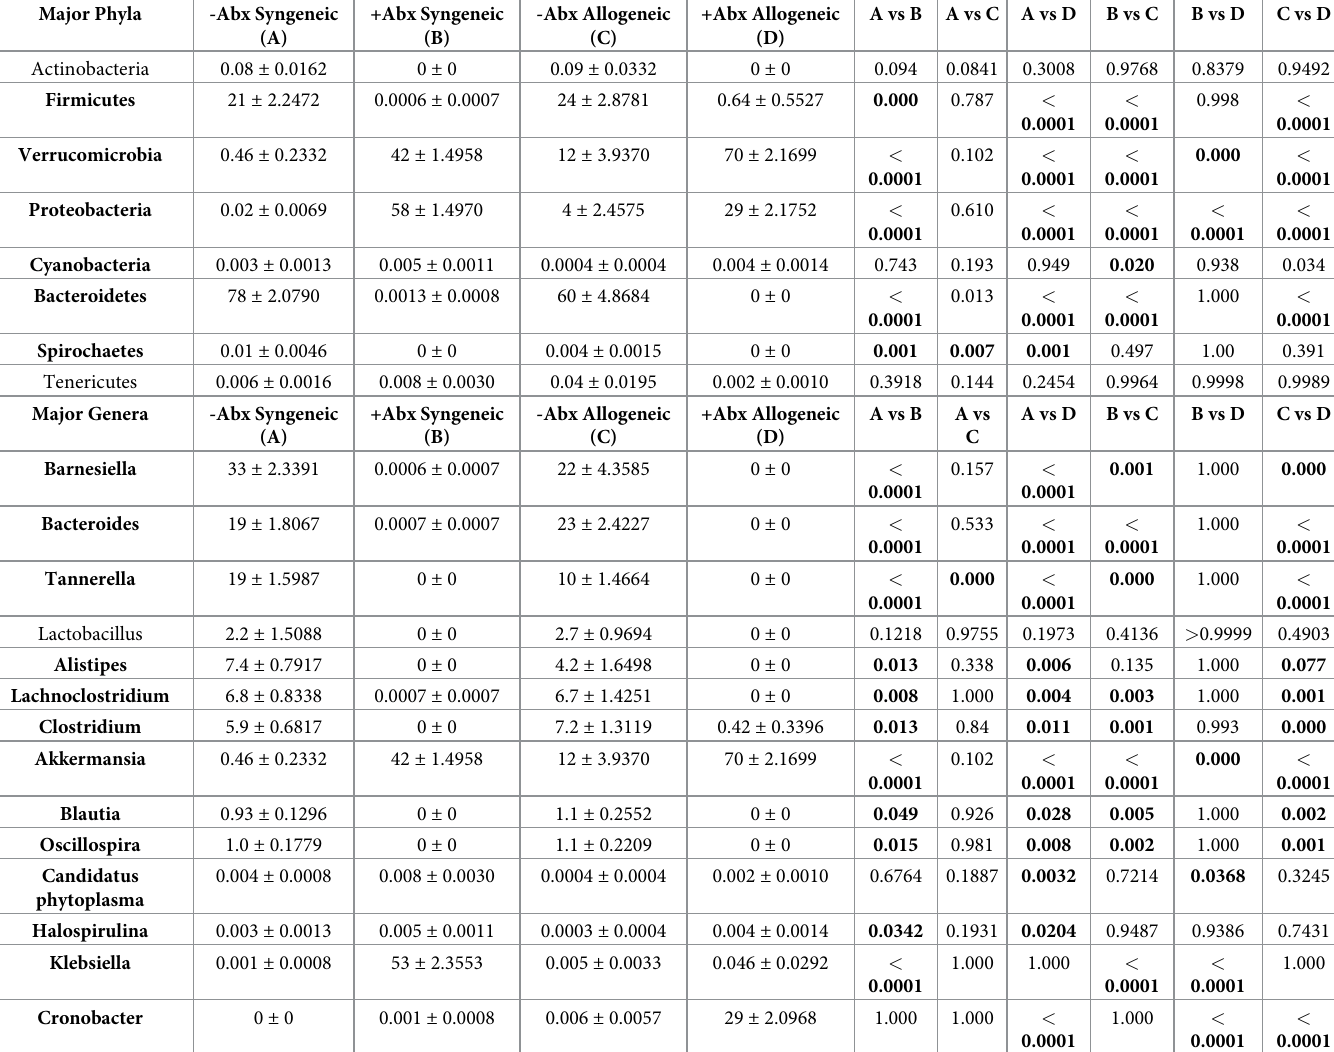
Table 3. Alterations in the major bacterial phyla and genera in untreated or Abx-treated mice engrafted with T